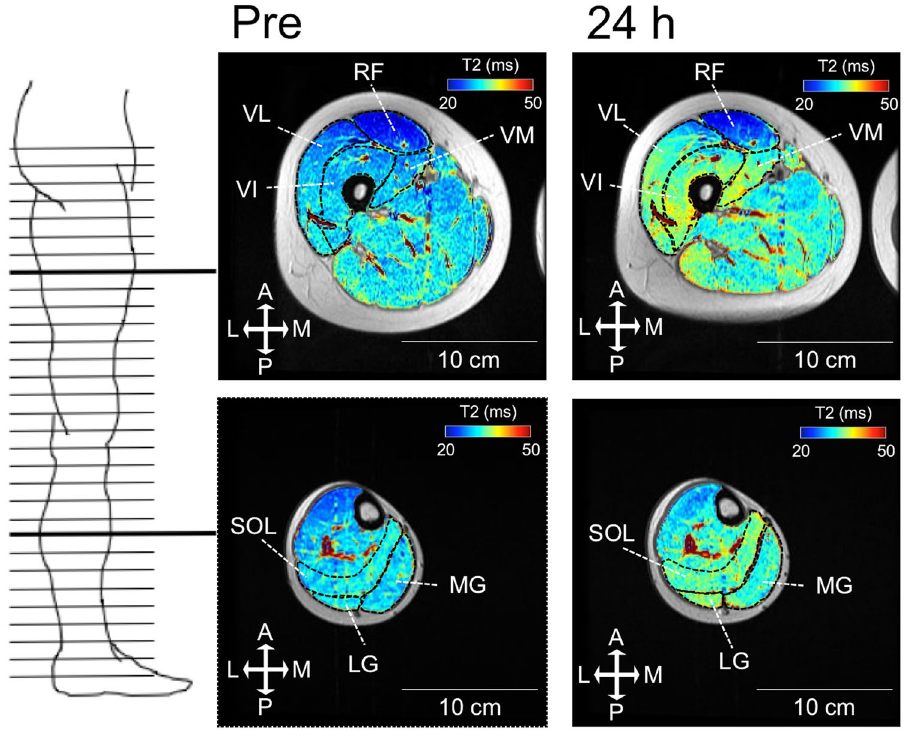
Figure 1. Examples of T 2 maps superimposed on T 2 -MRIs at middle sites for the VI (KEs, upper figures) and SOL (PFs, lower figures) scanned before (pre, left) and 24 h after (right) the downhill running task for one participant are shown. T 2 : transverse-relaxation time, MRI: magnetic resonance imaging, RF: rectus femoris, VI: vastus intermedius, VL: vastus lateralis, VM: vastus medialis, LG lateral gastrocnemius, MG medial gastrocnemius, SOL: soleus, A, M, P, L: anterior, medial, posterior, and lateral side, respectively.